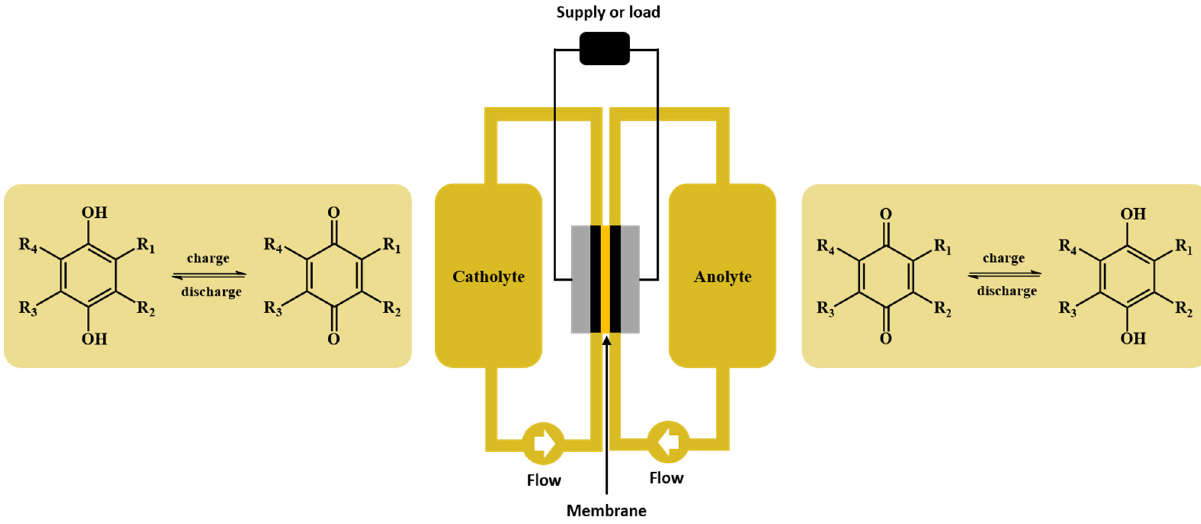
Scheme 1. Schematic representation of the redox flow battery setup and the redox reactions occurring upon charging and discharging of the battery.